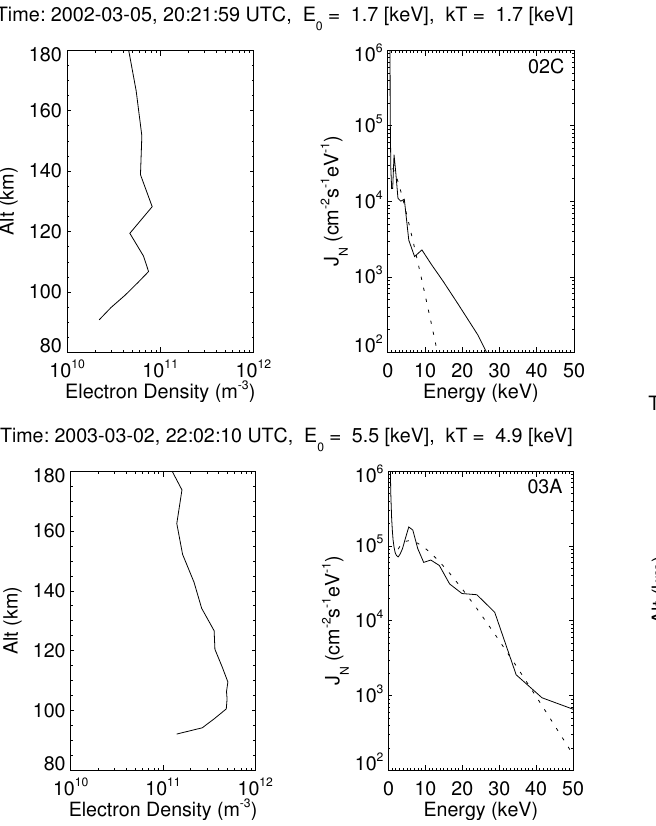
Fig. 9. The same as Fig. 7 but for events 03B and